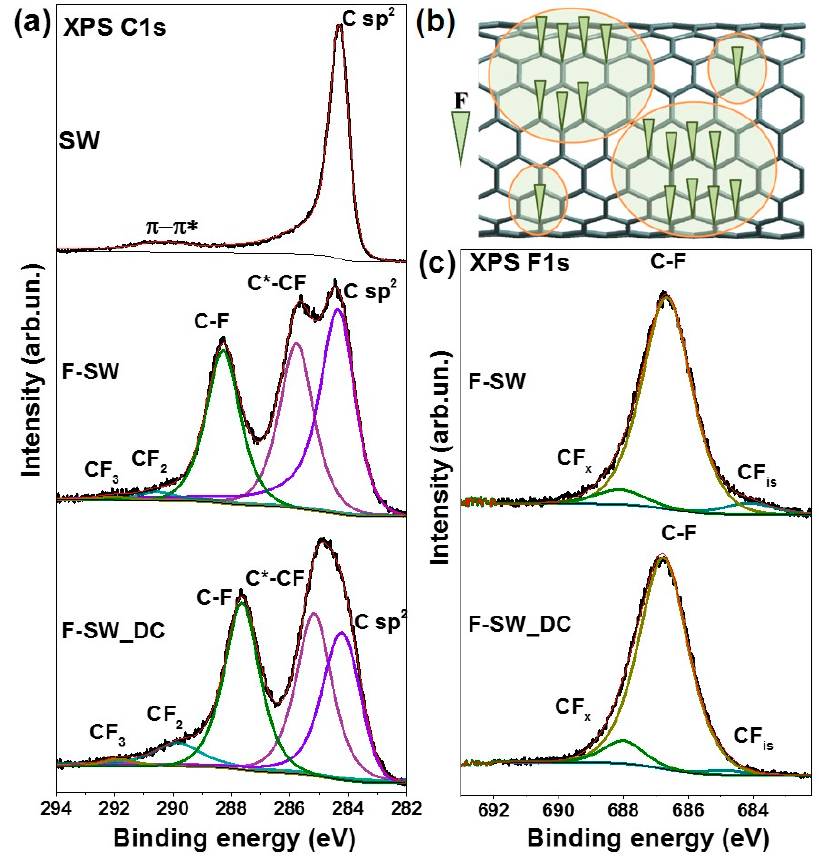
Figure 3. XPS C 1s spectra of initial SW film and fluorinated F-SW and F-SW_DC films ( a ). Schematic presentation of fluorine distribution on the SWCNT surface ( b ). XPS F 1s spectra of F-SW and F-SW_DC films ( c ).